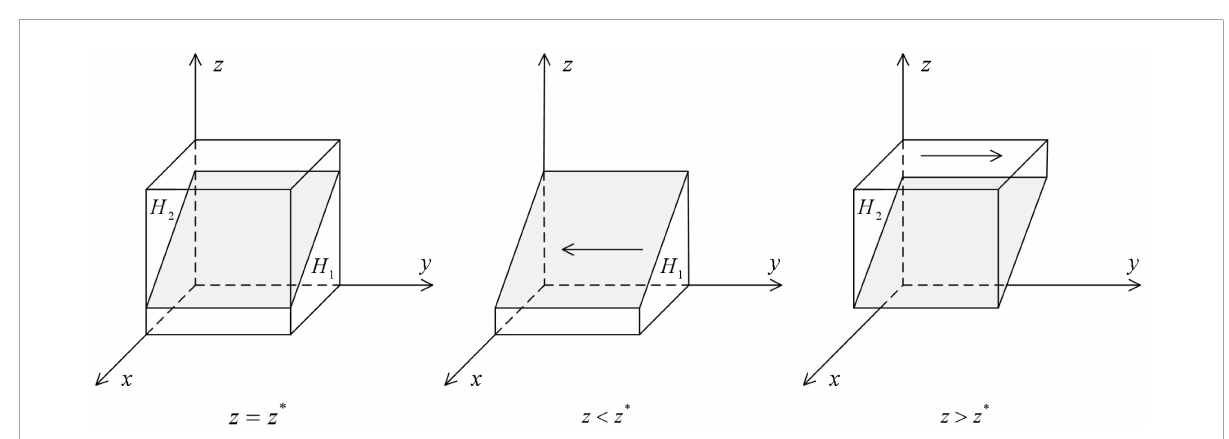
FIGURE2 Impact of changes in the probability of strategy of patients on the ESS of medical